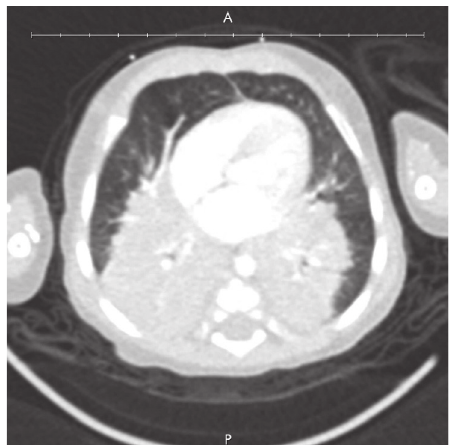
Figure 1: Computed tomography of the chest demonstrating large bilateral perihilar opacities at